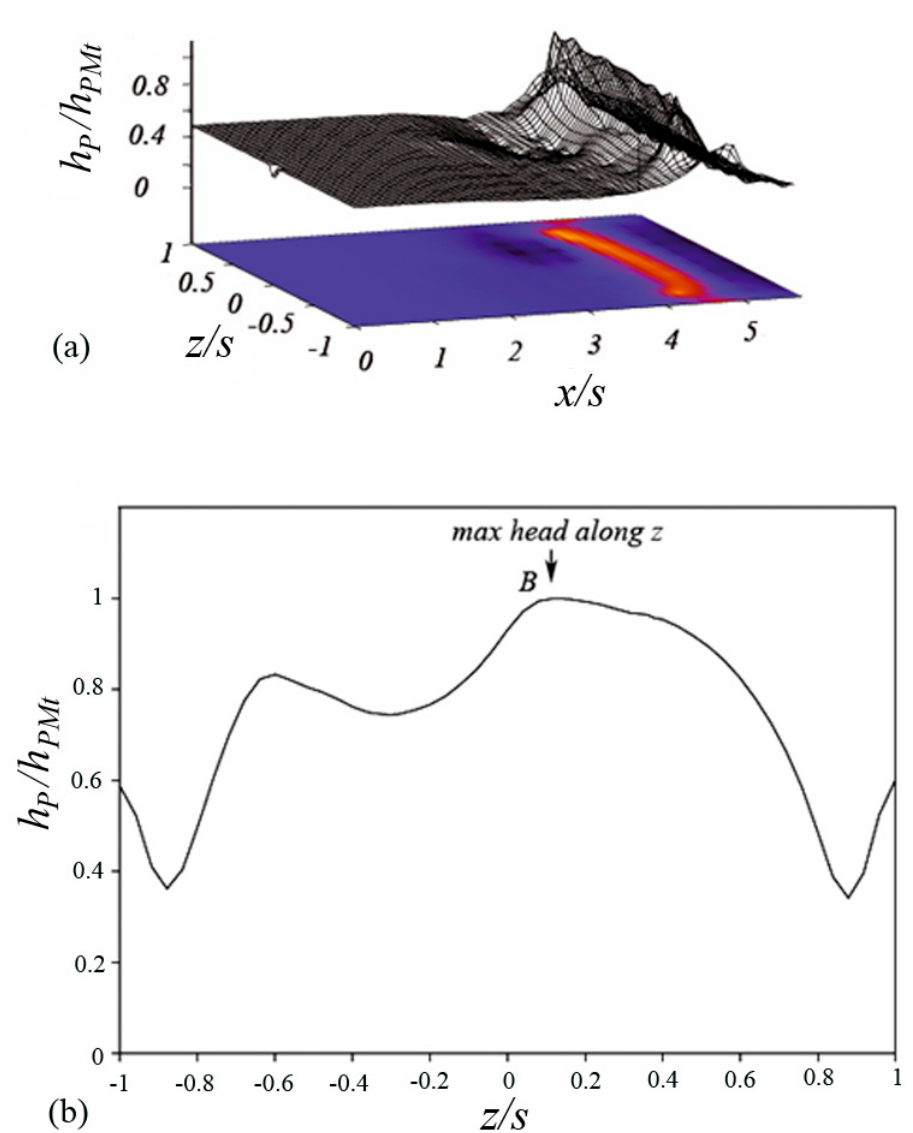
Figure 7. Behavior of the dynamic pressure head on the tailwater channel for F 0 = 5 and R = 0.10 m, β = 40°, h 0 = 0.05 m, test no. 27 in Table 1: ( a ) three-dimensional depiction of the nondimensional dynamic pressure head; ( b ) distribution of nondimensional dynamic pressure head along the z -axis.